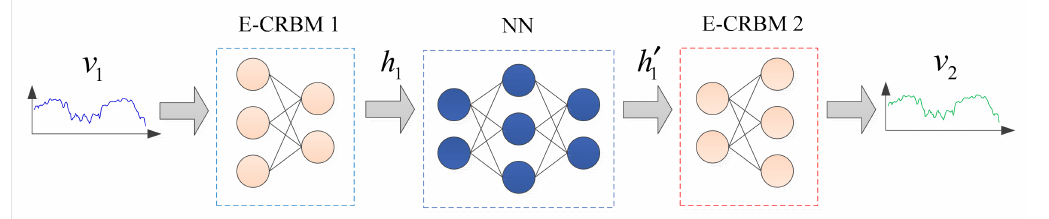
Figure 8. Prediction model based on